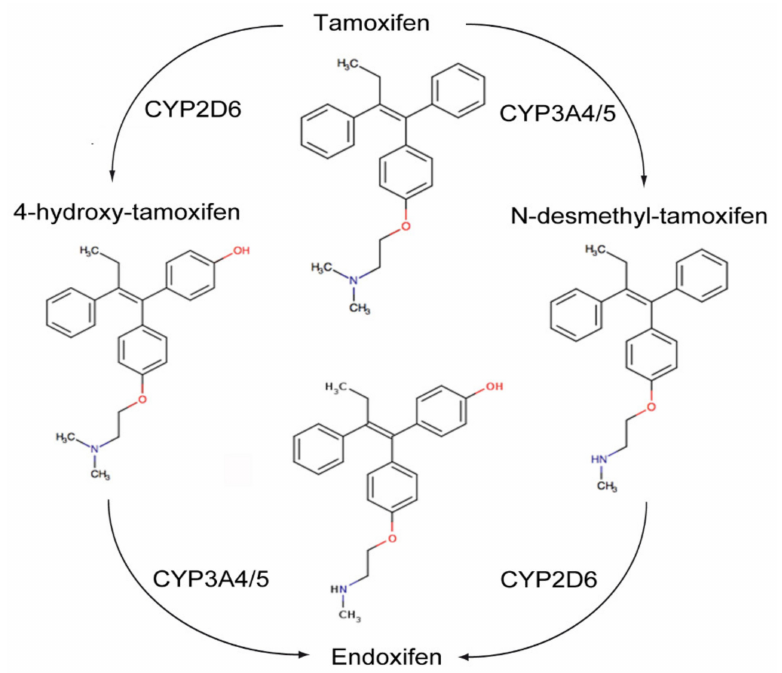
Figure 5. Metabolism of